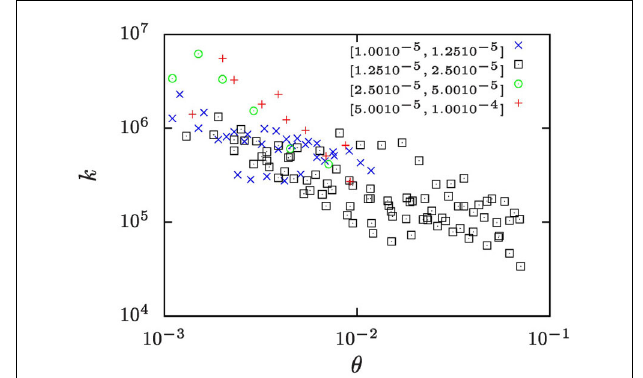
FIGURE 8 | The k -values for the water-rich phase of water/iso-butoxyethanol mixtures as a function of the reduced temperature θ = ( T − T c )/ T c where T c = 25 . 5 ◦ C is the critical temperature of the mixture. Different symbols refer to measurements where the volume-fraction growth rates, ξ , take values in the intervals indicated in the legend of the plot. The values of k have been calculated based on number densities n reported by Lapp et al. [25], and the other material parameter are extrapolations of the respective literature data which have been collected by Lapp